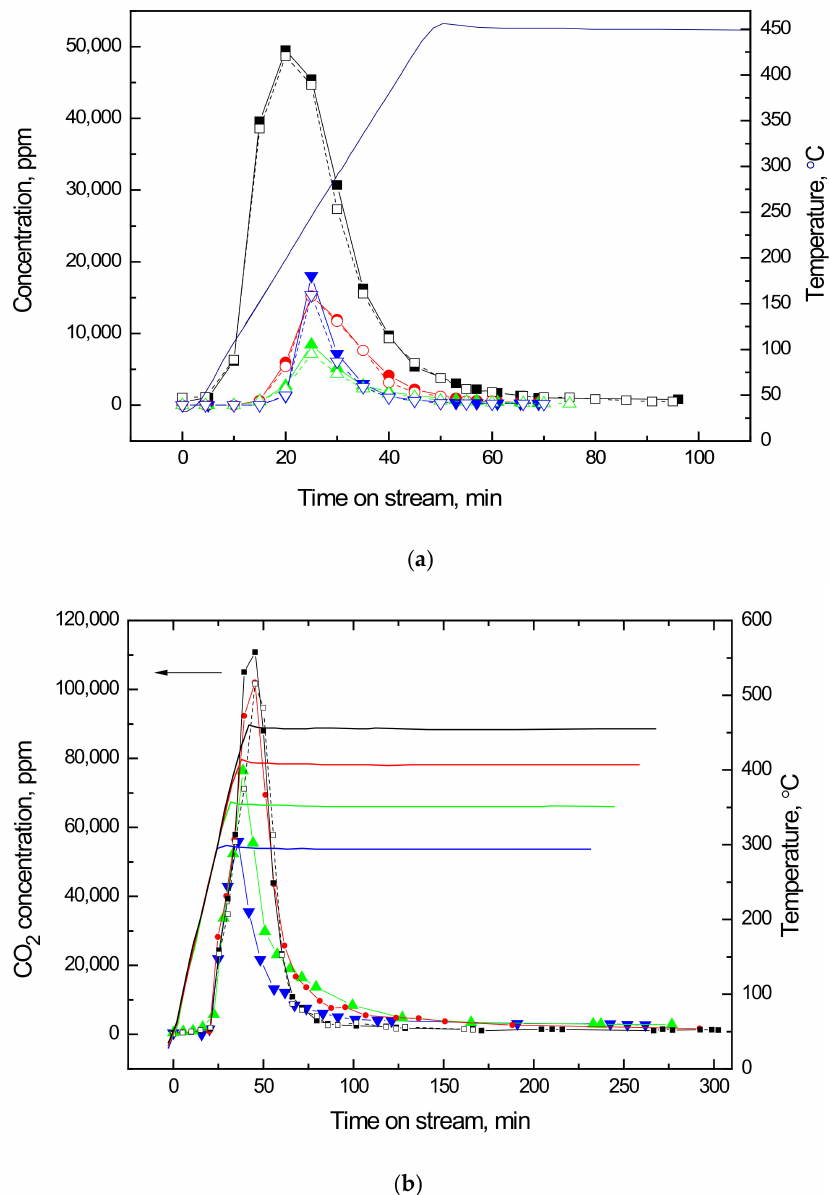
Figure 2. ( a ) Ethanol desorbed and species formed in the first (solid line) and second cycle of regeneration (dashed line) at 450 ◦ C of EtOH-laden V 2 O 5 /NaY-SiO 2 : ethanol desorption (black (cid:4) ), acetaldehyde formation (red • ), DEE formation (green (cid:78) ), ethylene formation (blue (cid:72) ); solid blue line in the figure is the temperature profile. ( b ) CO 2 formed in air regeneration of EtOH-laden V 2 O 5 /NaY-SiO 2 at an elevated temperature of 450 ◦ C (black (cid:4) ; first cycle, solid line; second cycle, dashed line), 400 ◦ C (red • ), 350 ◦ C (green (cid:78) ), and 300 ◦ C (blue (cid:72)